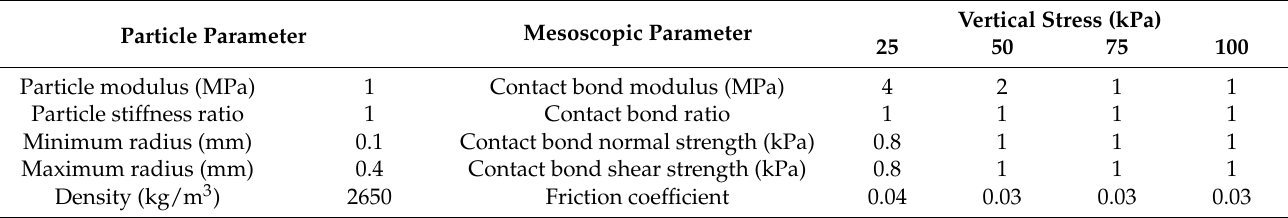
Table 1. Mesoscopic parameter values of DEM under different vertical